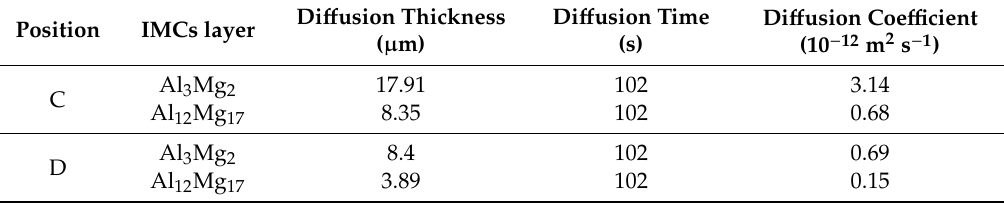
Table 4. Di ff usion coe ffi cients of aluminum (Al) / magnesium (Mg)